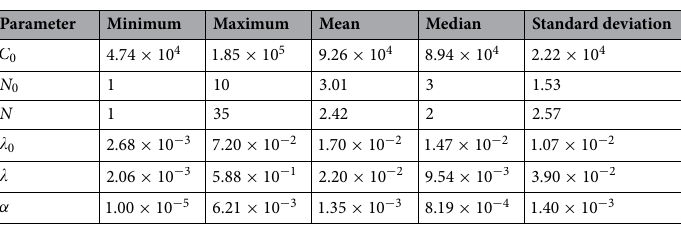
Table 4. Summary statistics of F5 clonotype posterior distributions for the multi-stage